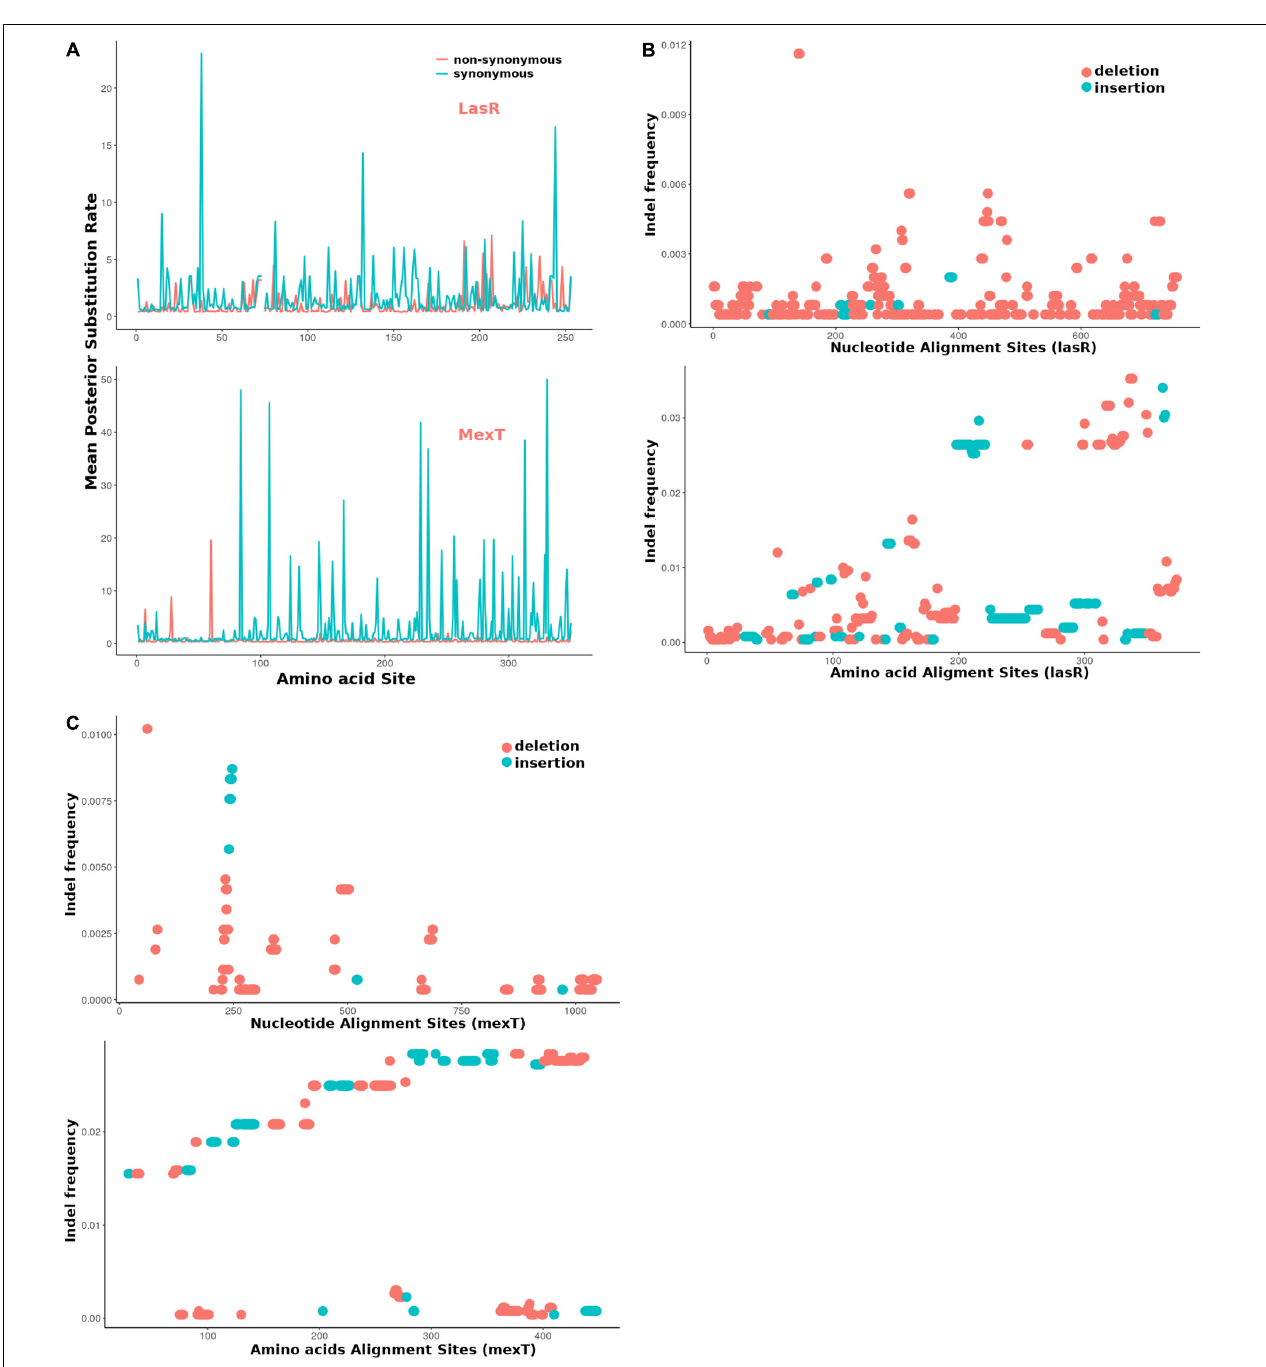
FIGURE 6 | The mexT and lasR sequence substitution rate in P. aeruginosa. (A) The nonsynonymous (orange peaks) and synonymous (green peaks) substitution rate in the amino acid sequences of LasR (top) and MexT (down). (B) The indel frequency of LasR nucleotides (up) and amino acid sequences (down) in P. aeruginosa strains. (C) The indel frequency of MexT nucleotides (up) and amino acid sequences (down) in P. aeruginosa strains. The deletion and insertion are indicated with orange and green dots.